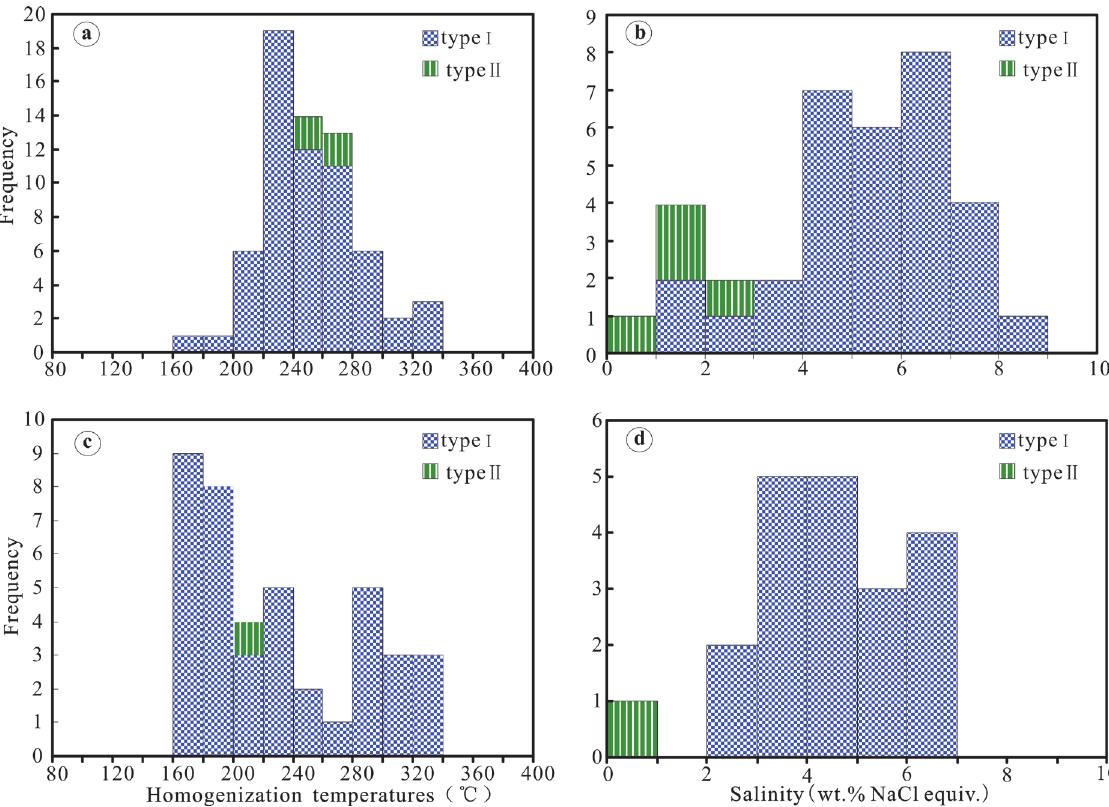
Figure 6. Histograms showing homogenization temperatures and salinities of fluid inclusions in two types of orebodies from the Nibao gold deposit: ( a ) histograms showing homogenization temperatures of fluid inclusions in the main-stage quartz of Sbt; ( b ) histograms showing salinities of fluid inclusions in the main-stage quartz of Sbt; ( c ) histograms showing homogenization temperatures of fluid inclusions in the main-stage quartz of fault F1; ( d ) histograms showing salinities of fluid inclusions in the main-stage quartz of fault F1.